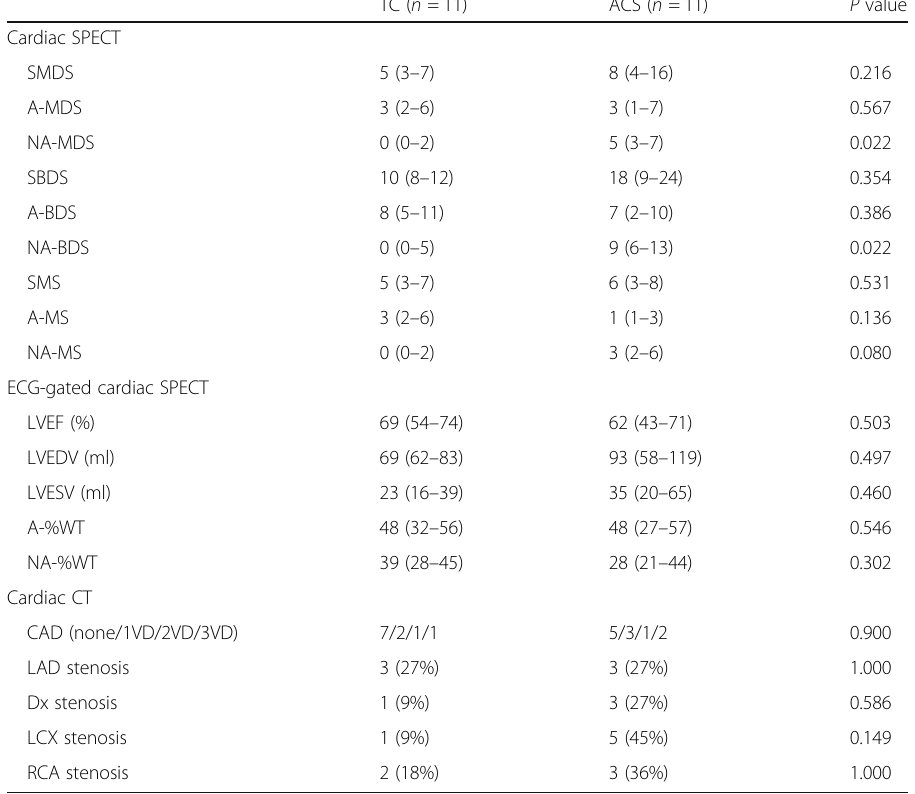
Table 3 Cardiac SPECT and CT